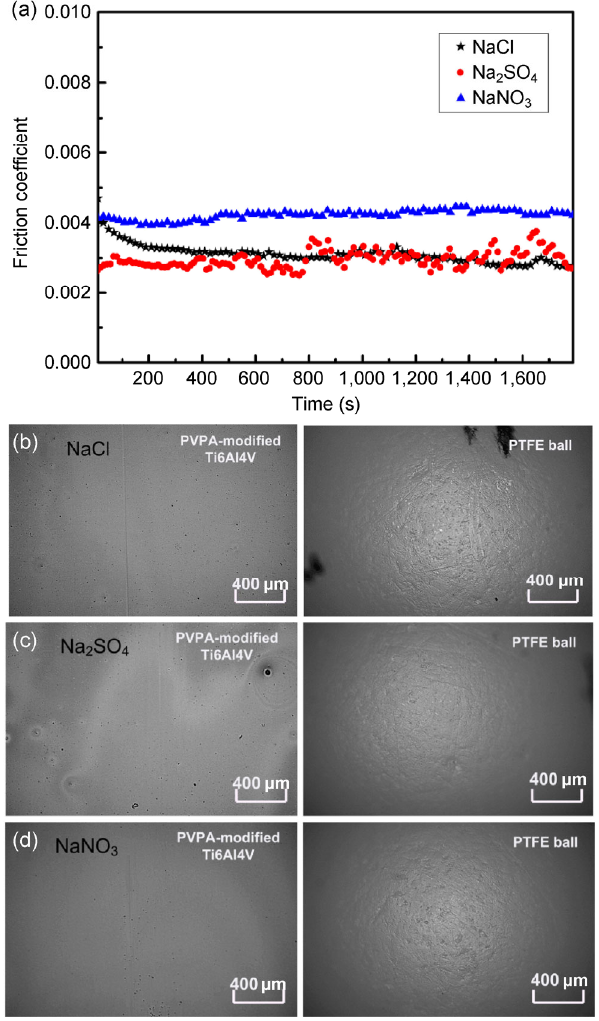
Fig. 5 Tribological properties of PVPA-modified Ti6Al4V in different lubricants: (a) average friction coefficients versus time, (b) surface topography on two tribo-pairs after sliding for 0.5 h in NaCl, (c) surface topography on two tribo-pairs after sliding for 0.5 h in Na 2 SO 4 , and (d) surface topography on two tribo-pairs after sliding for 0.5 h in NaNO 3